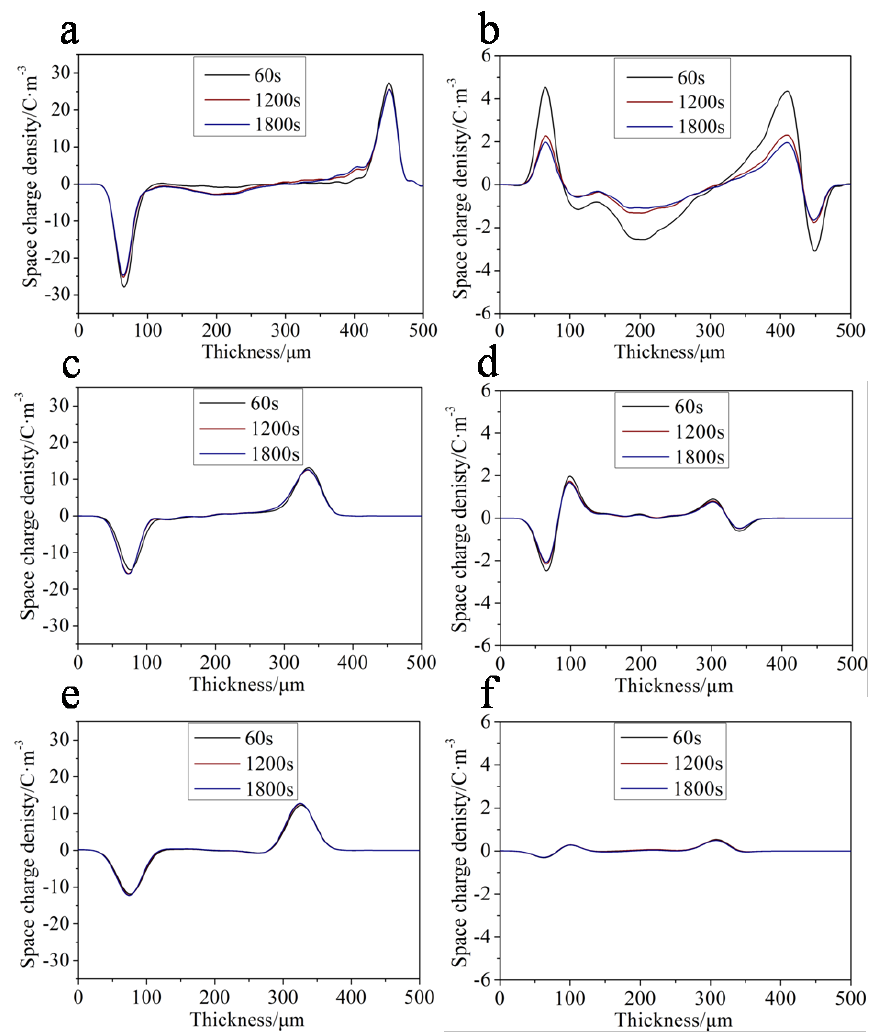
Figure 9. Space charge distributions ( a ) PE, ( c ) SEBS/PE, ( e ) Ac-SEBS/PE) and short circuit conditions ( b ) PE, ( d ) SEBS/PE, ( f ) Ac-SEBS/PE.